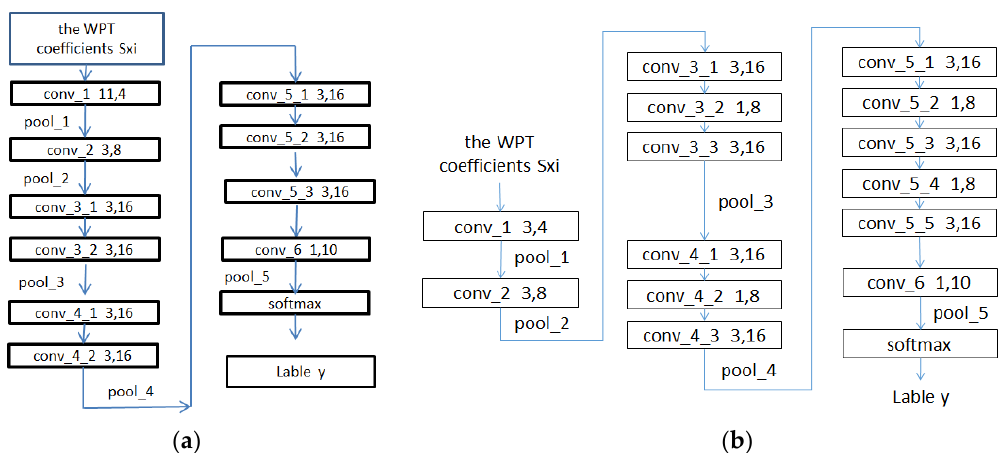
Figure 5. Structure of the CNN diagram: ( a ) The WPT-CNN network structures of model 1; ( b ) The WPT-CNN network structures of model 2.